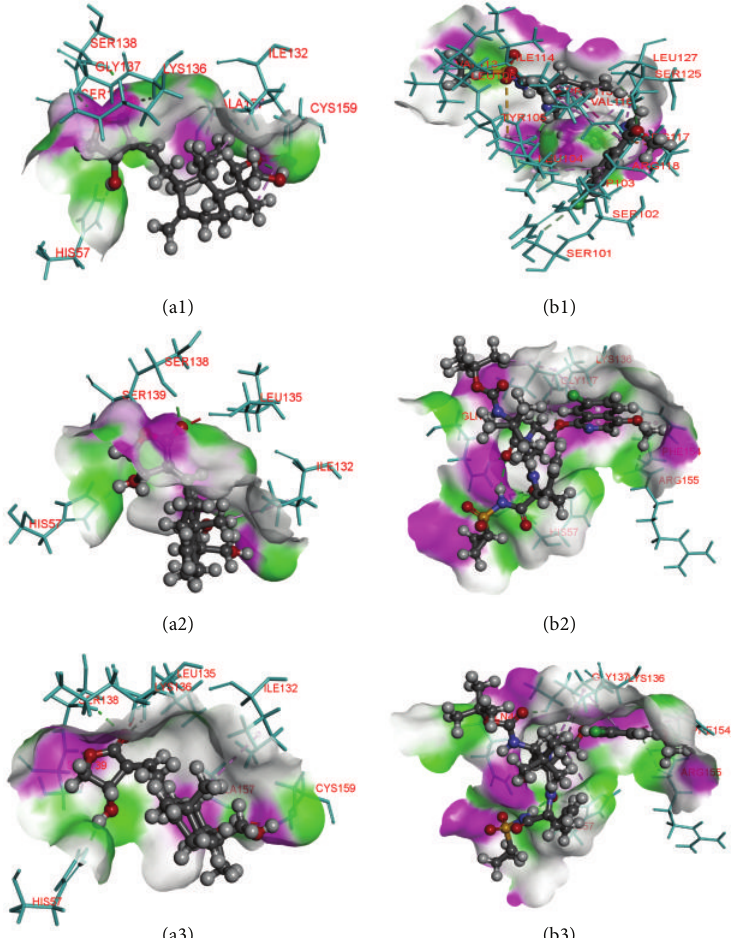
Figure 4: Binding poses and atomic interactions between ligands and receptors. (a1, a2, a3) series depicts Andrographolide interactions with the wild-type mutant R155K, and mutant D168A, respectively. (b1, b2, b3) series depicts the same with Asunaprevir and mutants in the same order above (see text for interacting residues). Note: ligands shown in ball-and-stick pattern and interacting residues shown in stick pattern, protein surface. Pink: donor, green: